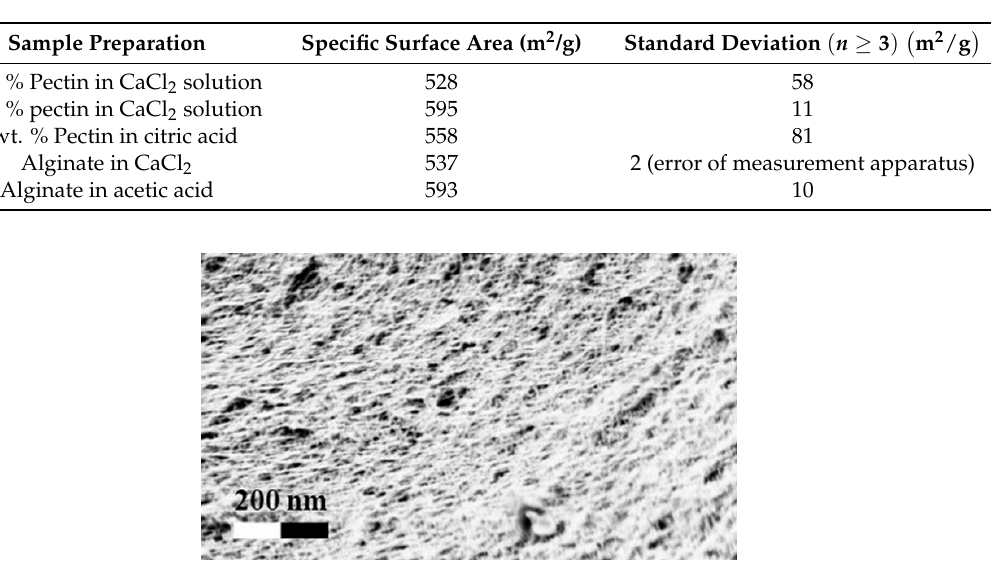
Table 5. Average specific surface areas of produced aerogel particles.